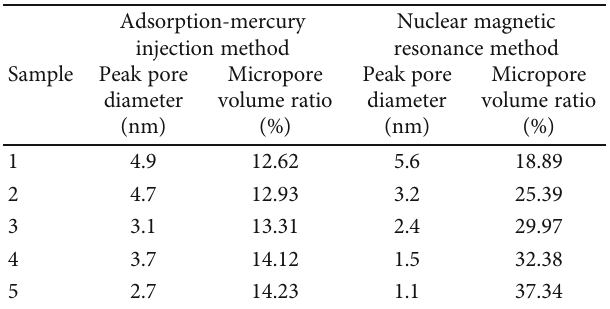
Figure 6: Pore size distribution characteristics obtained by NMR. Table 2: Peak aperture and micropore volume ratio measured by di ff erent